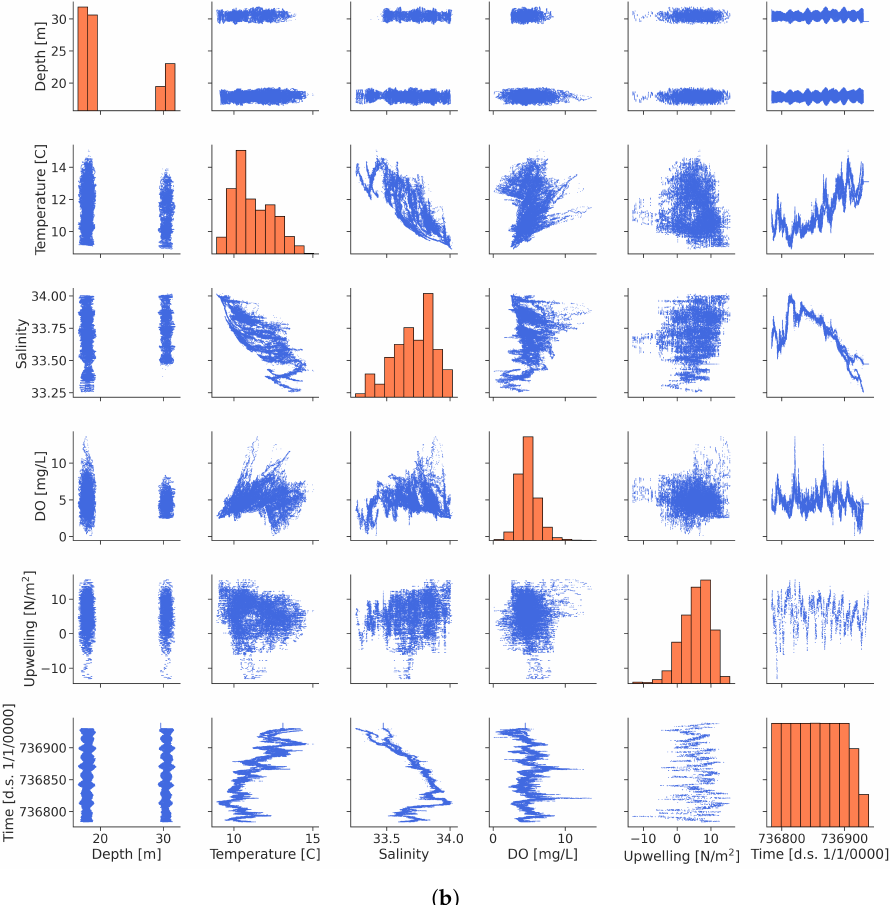
Figure 2. Pairwise relationships between all featured variables for the ( a ) offshore data and ( b ) nearshore data. Each plot shows a two-dimensional (2D) scatter plot of the variables labeled at that specific row and column. A histogram of value frequency for each quantity is shown in the main diagonal of the plots grid.